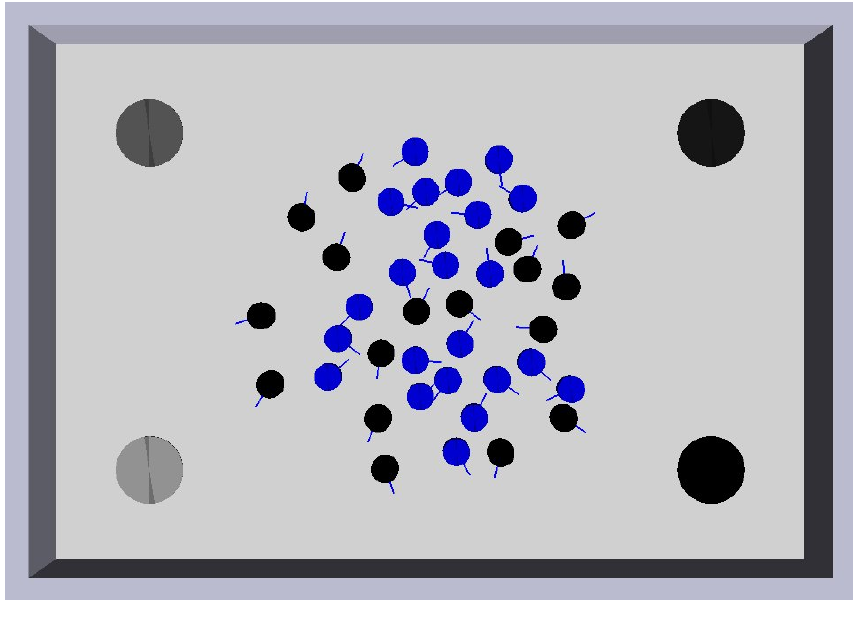
Figure 1. Simulator screenshot. Experimental setup included 40 robots engaged in search for 4 targets of different qualities represented by different grey-level intensity. Robots are programmed for obstacle avoidance; when robot detects an obstacle its color changes from black to blue to mark its new state. Once the robot has taken a new direction, its color goes back to